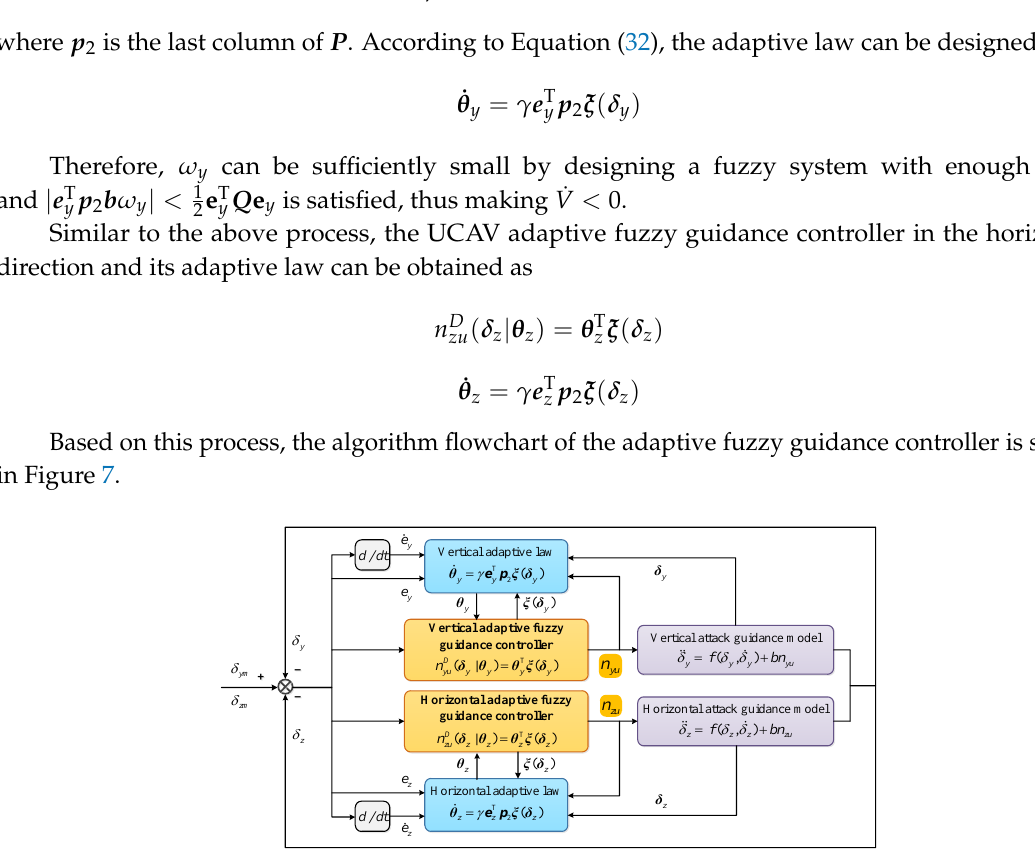
Figure 7. Algorithm flowchart of the adaptive fuzzy guidance